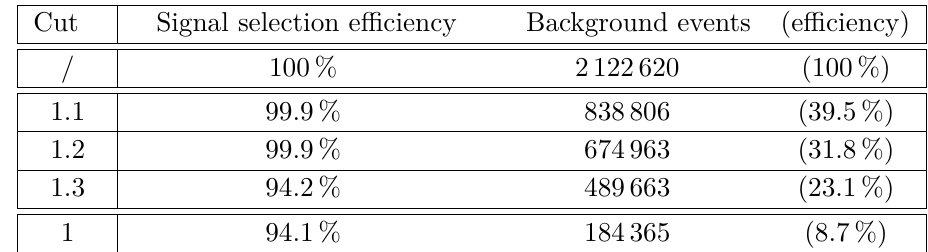
Table 2 . Signal and background selection efficiencies and total numbers of background events for event preselection cuts in the reference signal and 10 megaton · years background samples. The cut labeled as 1 combines cuts 1.1, 1.2 and